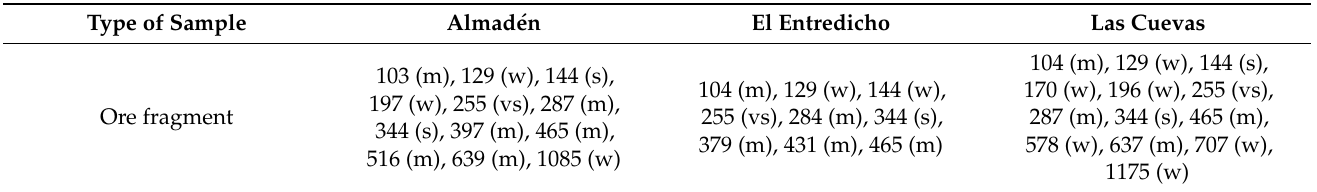
Table 2. Raman bands detected on each mineral ore (Almad é n, El Entredicho, Las Cuevas) using the confocal Raman